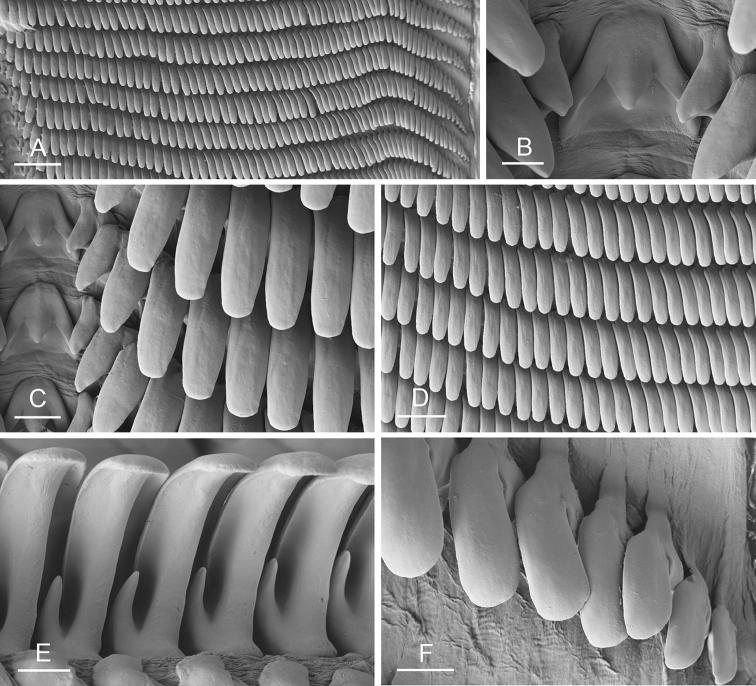
Radula, Peronia
madagascariensis, South Africa, [5841] (NMSA W7547) A right half rows of teeth B rachidian and innermost lateral teeth C rachidian and innermost lateral teeth D lateral teeth E lateral teeth, frontal view F outermost lateral teeth. Scale bars: 200 μm (A), 20 μm (B, E, F), 40 μm (C), 100 μm (D).